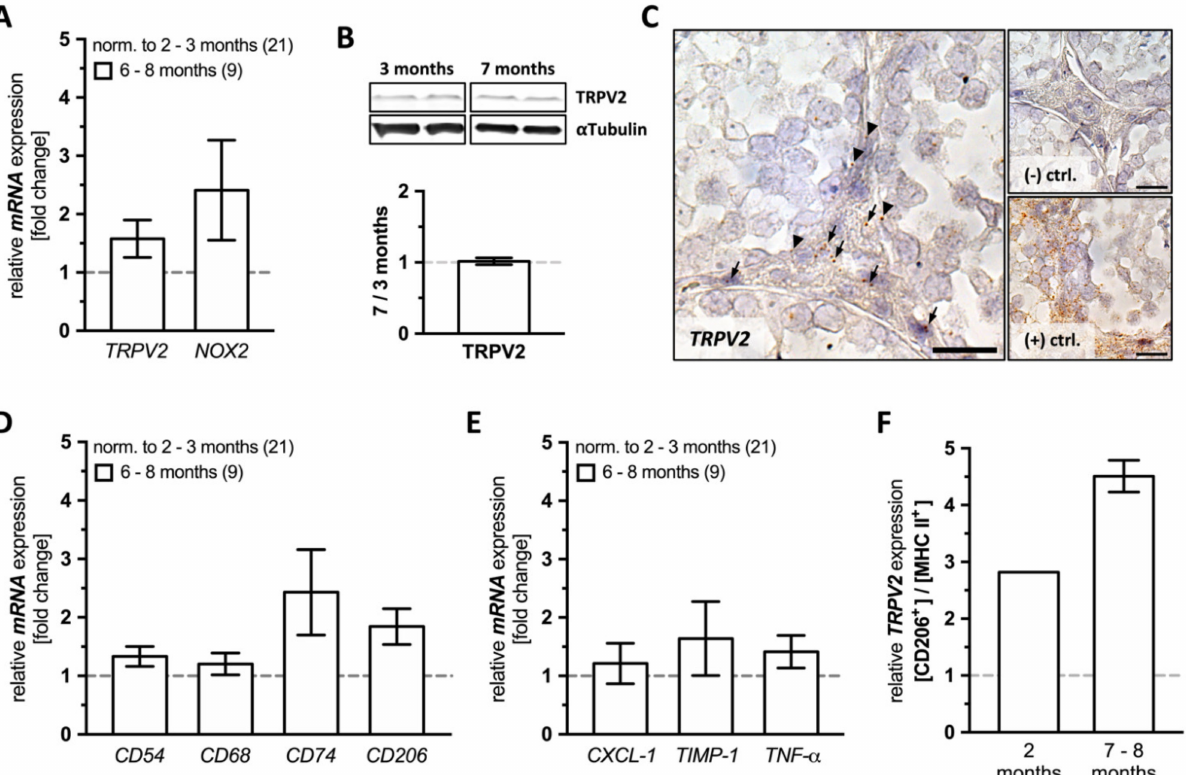
Figure 1. Expression profile of TRPV2 , NOX2 , macrophage and inflammation markers in WT testes. ( A ) Relative mRNA expression levels of TRPV2 and NOX2 in whole testes of old WT mice, normalized to young animals. Levels were not significantly different ( TRPV2 : 1.578 ± 0.319, p = 0.3505; NOX2 : 2.412 ± 0.856, p = 0.2802). ( B ) TRPV2 immunoblotting of young (3 months, n = 2) and old WT testes (7 months, n = 2) showed weak bands (~63 kDa) for both ages and quantification revealed a mean expression level in old WT testis of 1.016 ± 0.049, compared to young ones. Staining for α Tubulin was used as a loading control. ( C ) Testicular sections of 10 month-old WT mice subjected to TRPV2 in situ hybridization showed punctuated staining mainly in the interstitial space (arrows) with few spots at the peritubular walls (arrow heads; left panel). The negative control (upper right panel, ( − ) ctrl.) showed no signals, but the positive control (lower right panel, (+) ctrl.) did. Scale bar is 50 µ M. ( D , E ) Relative mRNA expression levels of ( D ) macrophage markers ( CD54 : 1.332 ± 0.172, p = 0.1157; CD68 : 1.205 ± 0.188, p = 0.8506; CD74 : 2.430 ± 0.732, p = 0.2402; CD206 : 1.843 ± 0.305, p = 0.0589) and ( E ) inflammation markers ( CXCL-1 : 1.214 ± 0.348, p = 0.6767; TIMP-1 : 1.638 ± 0.633, p = 0.7160; TNF- α : 1.416 ± 0.279, p = 0.5198) in whole testes of old WT mice normalized to young animals. ( A , D , E ) The graphs represent mean ± SEM of old WT mice (6–8 months, n = 9) normalized to young animals (2–3 months, n = 21); unpaired two-tailed t -test, α = 0.05. ( F ) Testicular macrophages from young (2 months, n = 1, pool of three animals) and old WT mice (7–8 months, n = 2, pool of three animals each) sorted for their CD206 and MHC II expression by FACS were subjected to mRNA extraction and quantitative RT-PCR for TRPV2 expression. The graphs represent mean ±